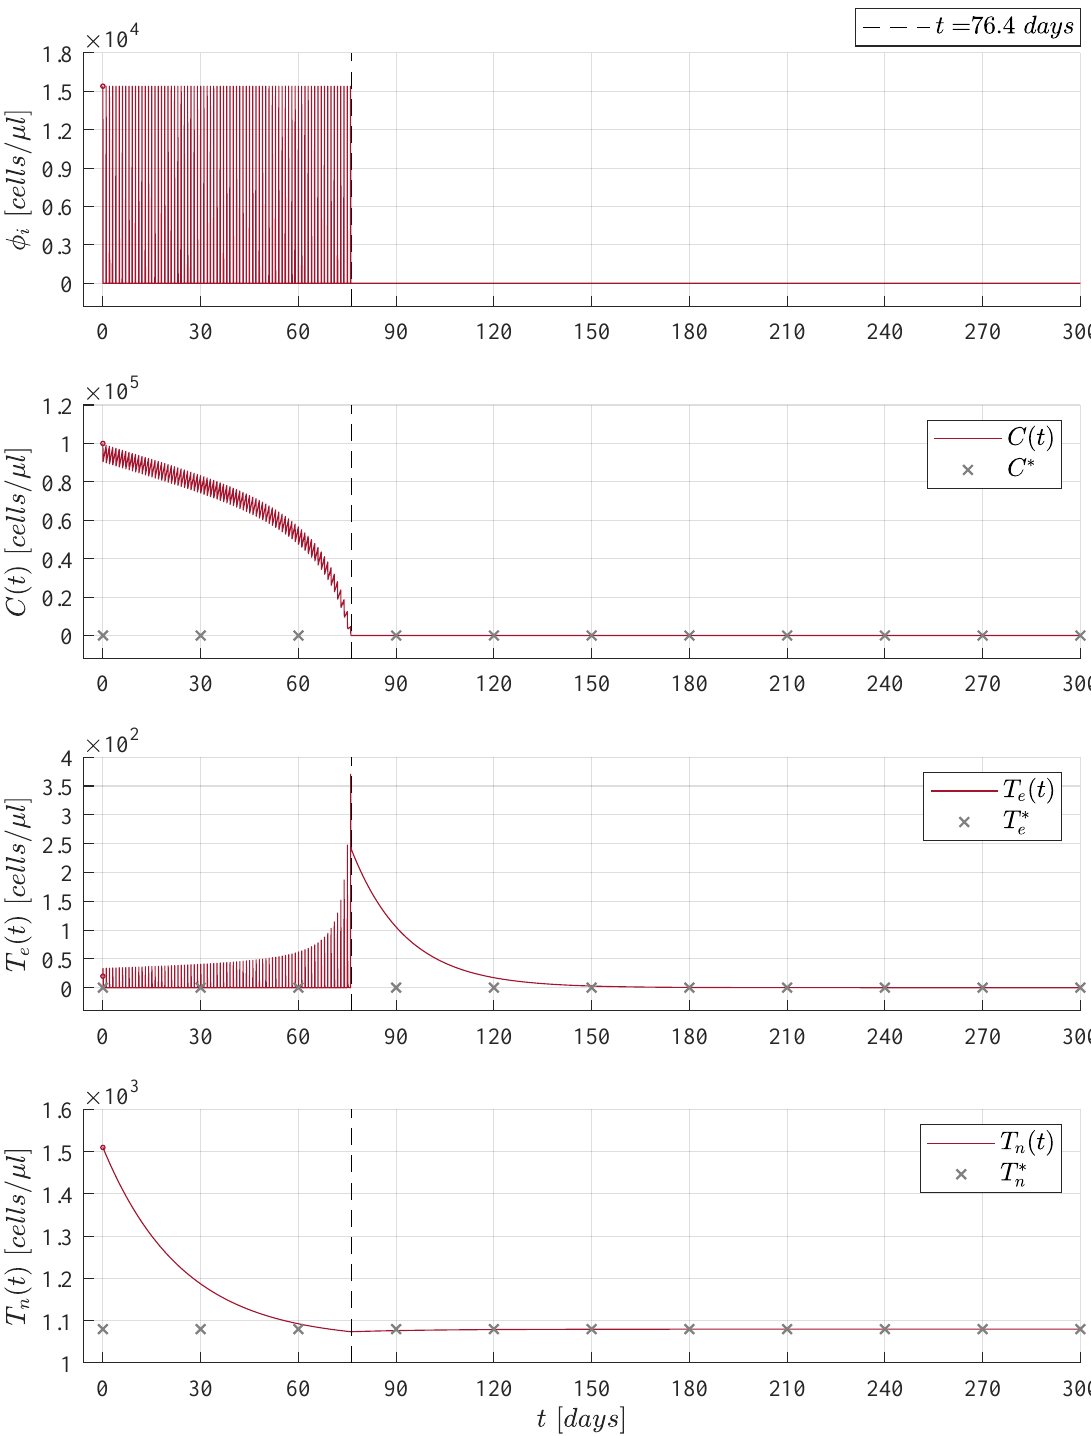
Figure 5. Case 3: The initial tumour size for the CML cancer cells is set as C ( 0 ) = 1 immunotherapy φ i had to be applied 76.4 days to achieve complete leukemia cancer cells